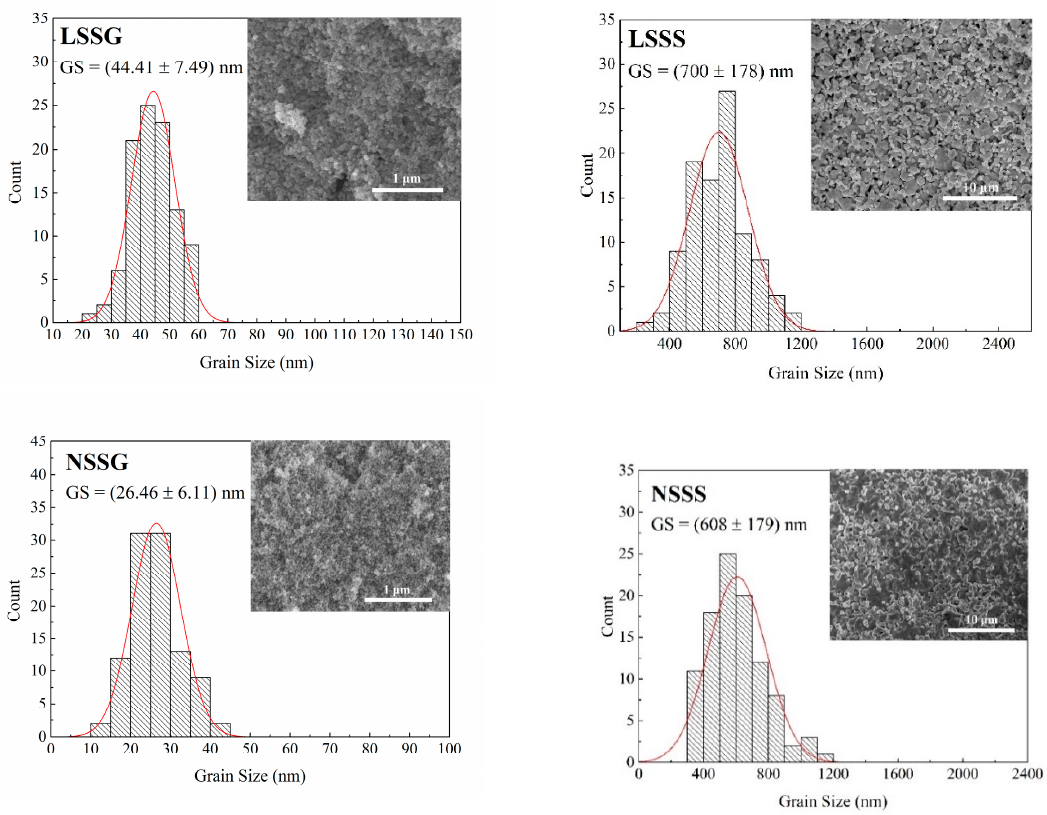
Figure 2. Grain size distribution histograms and FESEM micrographs of manganite samples.